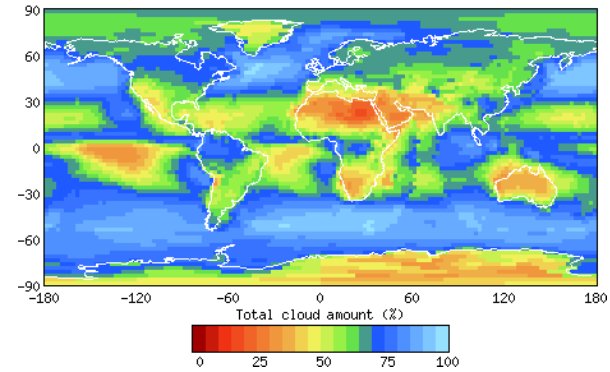
Figure 6. Map of the mean annual cloud amount for the pe- riod 1983–2009 from the International Satellite Cloud Climatol- ogy Project (ISCCP). Downloaded from https://isccp.giss.nasa.gov/ products/browsed2.html, last access: 2 January